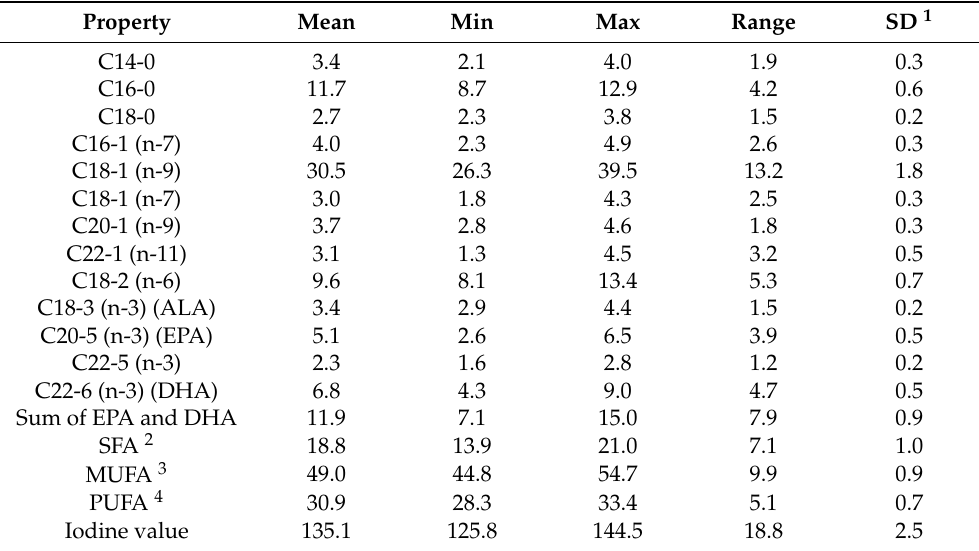
Table 1. Results from GC reference analysis of FAs and summed FA properties (percentage of total FA